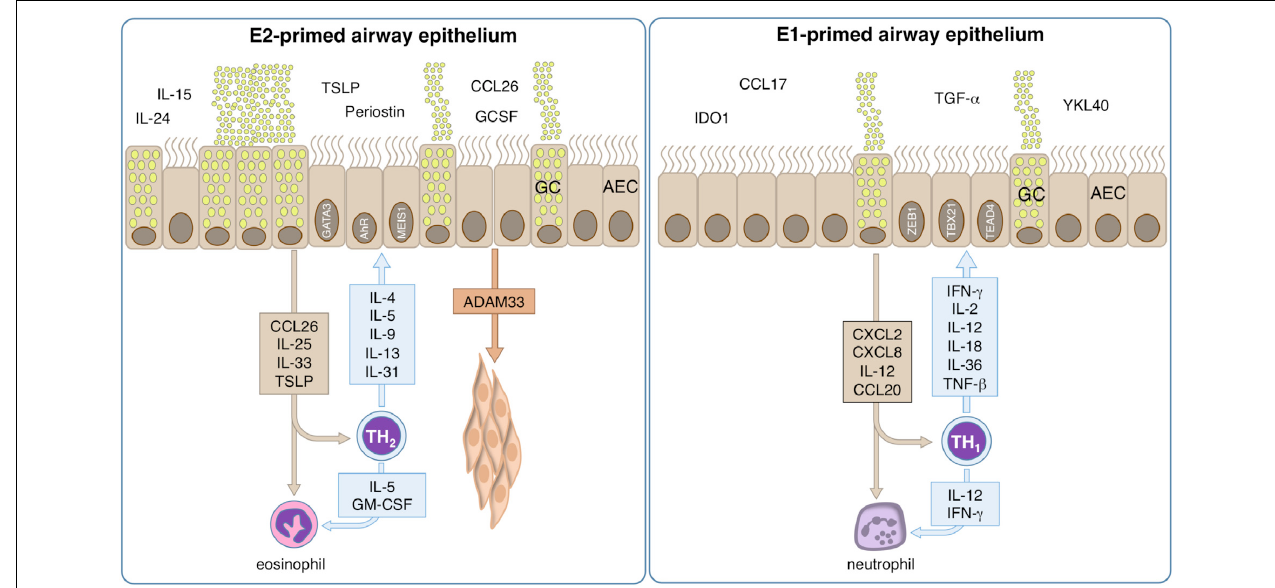
FIGURE 4 | Mechanisms of allergic inflammation in epithelial cells. The role of tissue cells in the early phase of disease is largely unknown, but could provide important information about the pathologic development and could help to identify the causal relationships. However, bronchial epithelial cells are pre-committed to a type-2 (E2) or type-1 (E1) like phenotype. E2 epithelial cell activation by allergens takes place and their pro-inflammatory cytokines and chemokines induce inflammation and contribute to an epithelial type-2 response, so called “E2 response” with epithelial alarmins TSLP, IL-31, CCL-26, IL-25, and IL-33. Local type-2 responses involve multiple cytokines such as IL-4, IL-5, IL-9, IL-13, IL-25, IL-33, and increase of eosinophils. A series of chemokines are produced and migration of inflammatory cells to the allergic tissues takes place. The activation of e.g., smooth muscle cells by ADAM33 lead to remodeling. Bronchial hyperreactivity